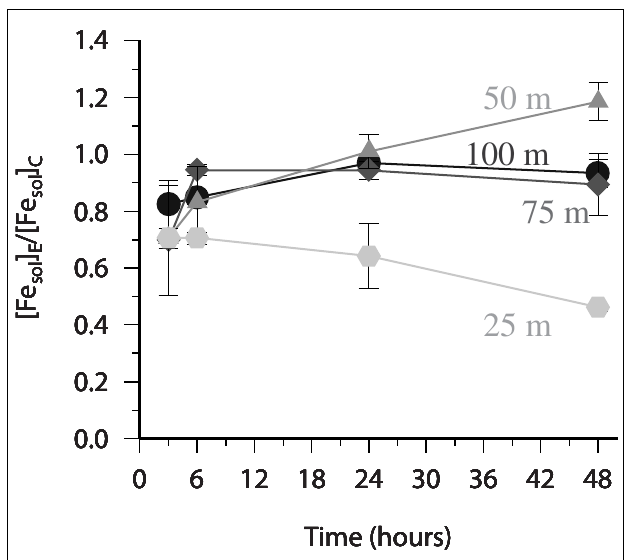
FIGURE 7 | FESOL-KIN: experiment at S279 duringANTXXVI-4 to which a thermal source of O − (SOTS-1) was added. Time variation of the 2 ratio ([Fe sol ] E /[Fe sol ] C ) of the data obtained from paired bottles where the soluble Fe was measured in both the presence (experimental-E) and absence (control-C) of the thermal O − source SOTS-1 for samples from the 2 upper 100m (25m hexagons, 50m triangles, 75m diamonds, 100m circles).There was no statistical significant variation (as assessed by paired t -test) in the ratio for samples below 100m.